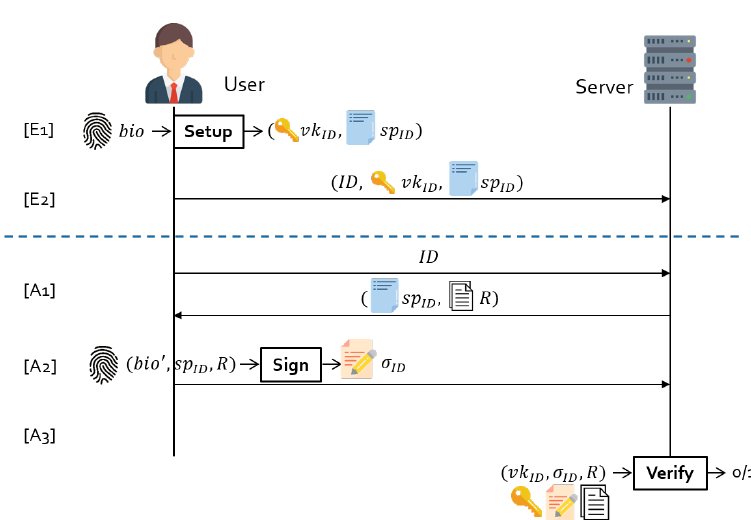
Figure 1. Authentication with a fuzzy extractor.